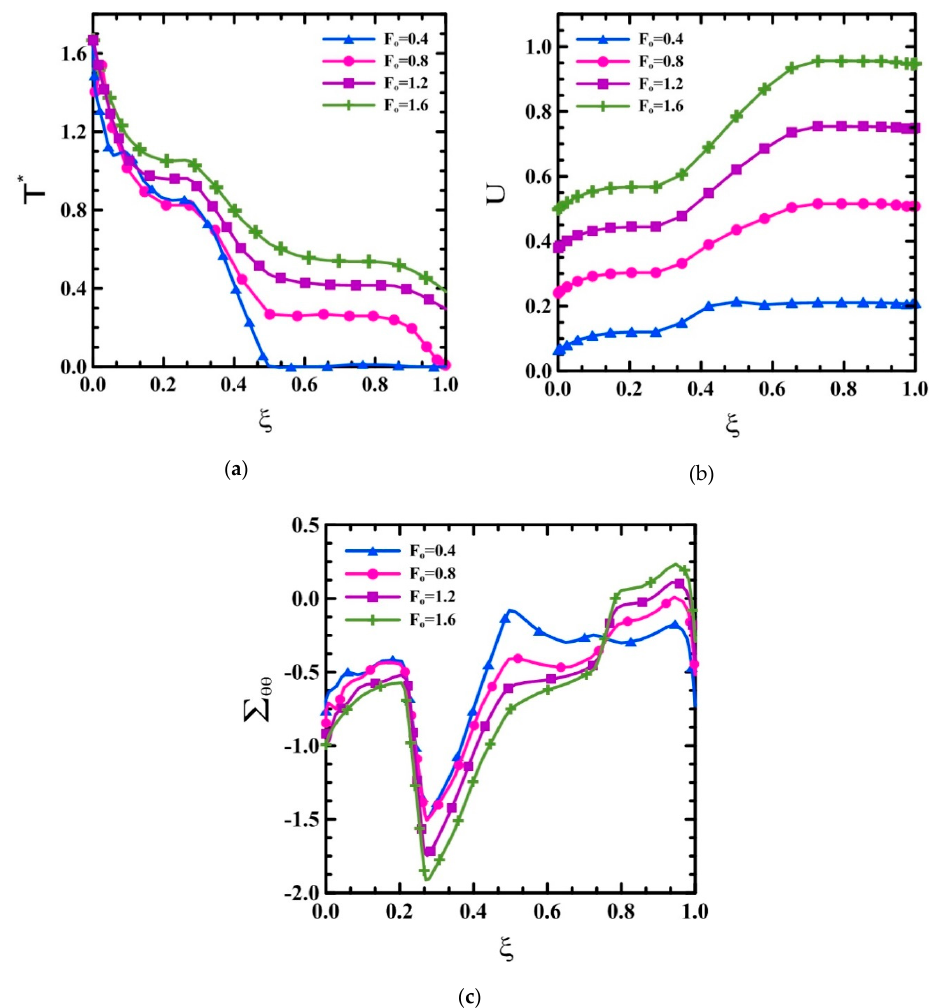
Figure 9. ( a – c ): Effects of different time levels on the distribution of the thermoelastic field variables through the radial direction n = 1, h c / h p = 5, θ 0 = 75 ◦ , θ = 0.5 θ 0 , ψ = 0.03, τ = 0.2